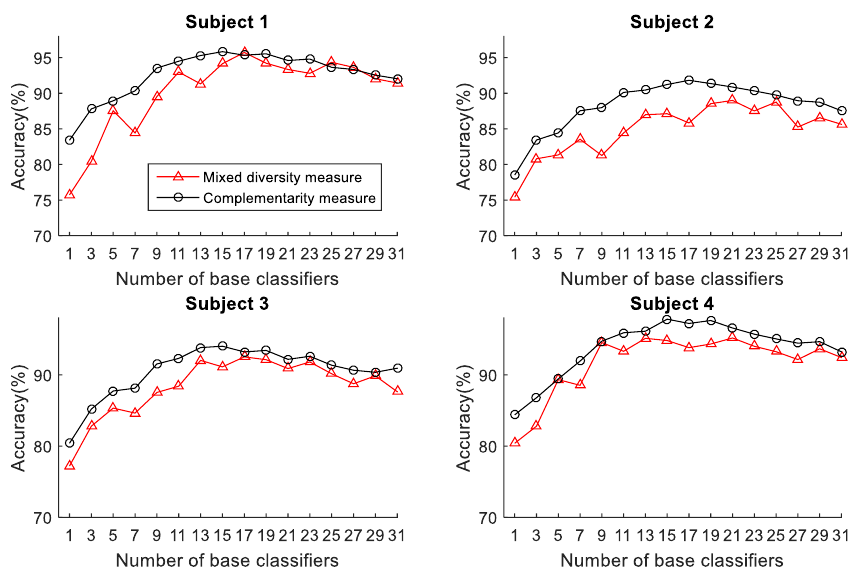
Figure 9. The relationship between the accuracy and the ensemble scale of the ELS in DSAD dataset.